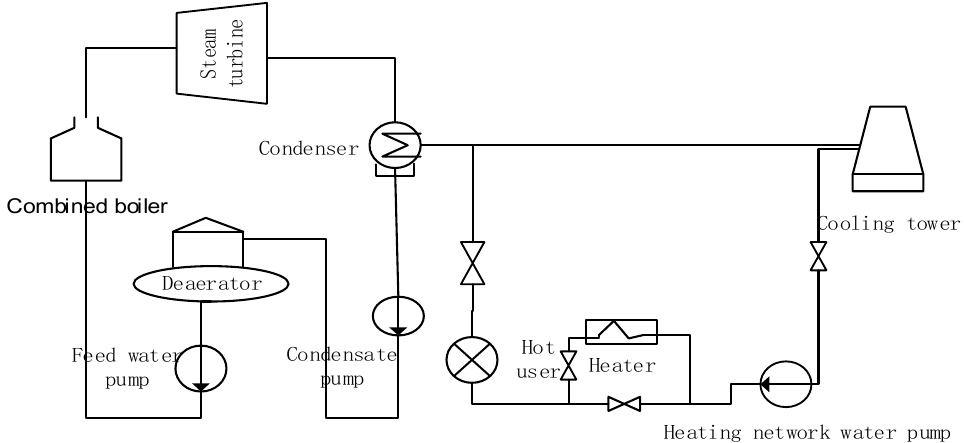
Figure 3. Schematic diagram of low-vacuum circulating water heating technology.